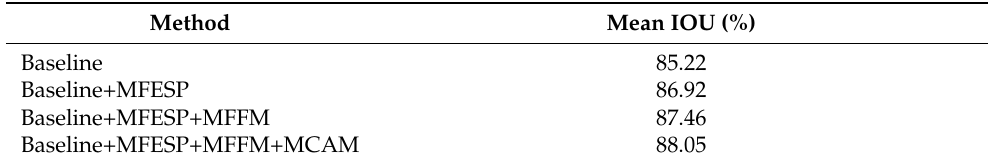
Table 1. Performance comparison of different modules in the model.